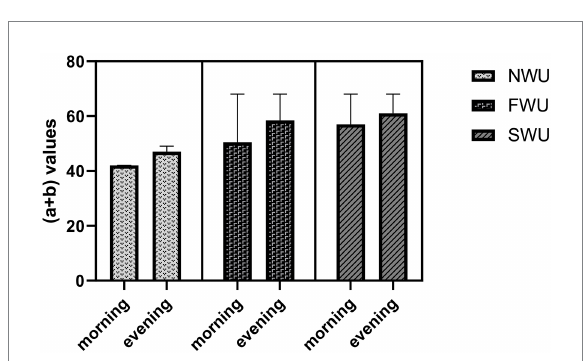
FIGURE 4 Uchi-komi Fitness Test (a + b) in the morning and evening hours for the three warm-up protocols. NWU, No-warm-up; SWU, Specific warm up; FWU, Linear and Lateral warm up.